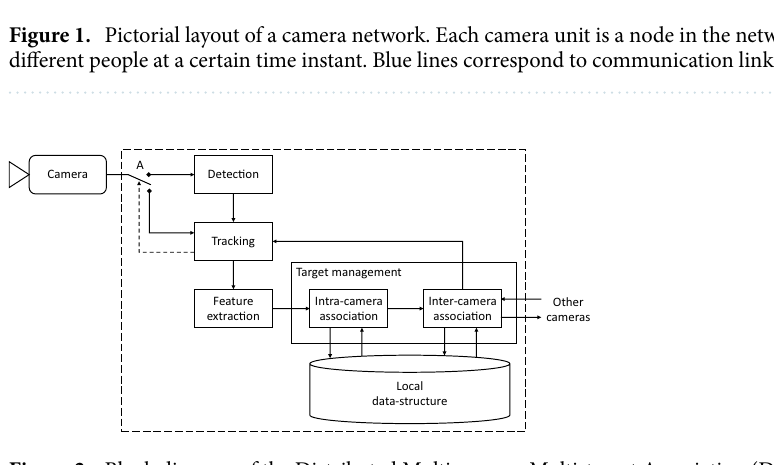
Figure 2. Block diagram of the Distributed Multi-camera Multi-target Association (DMMA). A: switch activated periodically or when the tracking confidence is low. Target management: receives in input the extracted features; deals with intra-camera and inter-camera associations, both by the Hungarian algorithm 7 ; communicates with the other cameras. Local data-structure is updated at each time